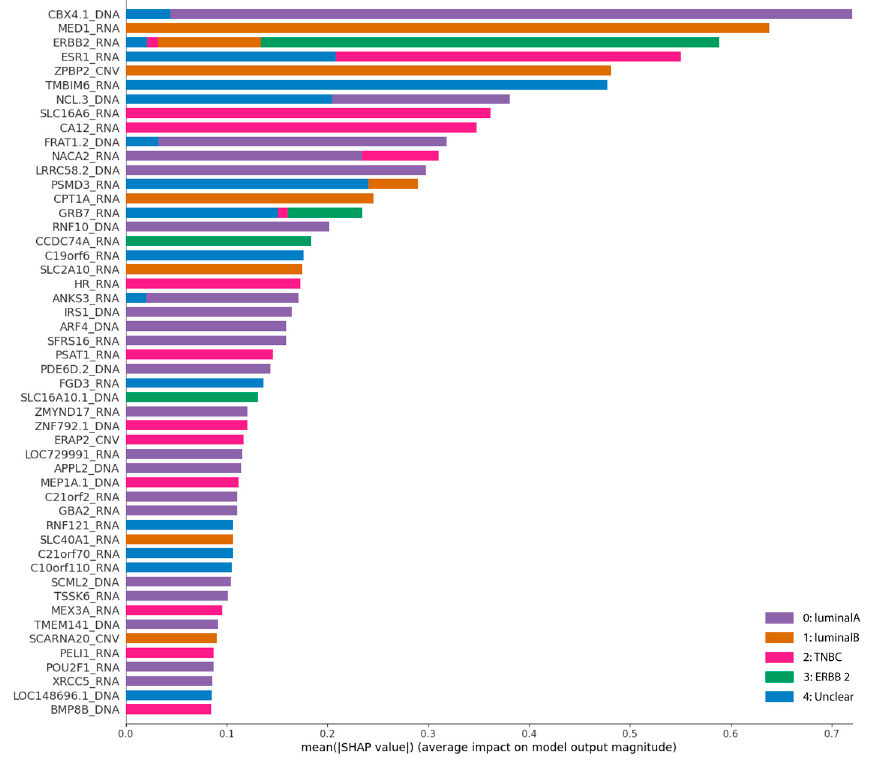
Figure 5. Baseline Hybrid SHAP Summary Plot.